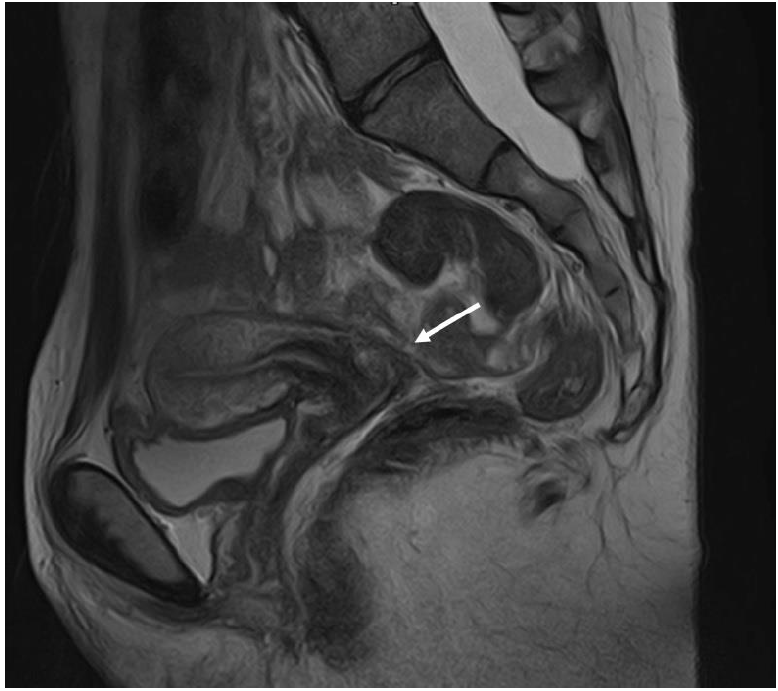
Figure 7. MRI imaging method: a retrocervical nodule indicated by an arrow in the sagittal plane. Furthermore, in the case of vaginal involvement, it is possible to identify direct and indirect findings. In the case of a direct finding, a nodule (with a low T2W signal) or the thickening of the parietal wall can be detected; in this case, the signal of the T1W sequence is also related to the presence and amount of hemoglobin in the hemorrhagic foci [77]. As an indirect sign, it is possible to find the obliteration of the pouch of Douglas that could be a sign of posterior vaginal involvement. In case of vaginal wall involvement, MRI could guide the surgery since the removal of the upper part of the vaginal wall is still mandatory for eradication [78].